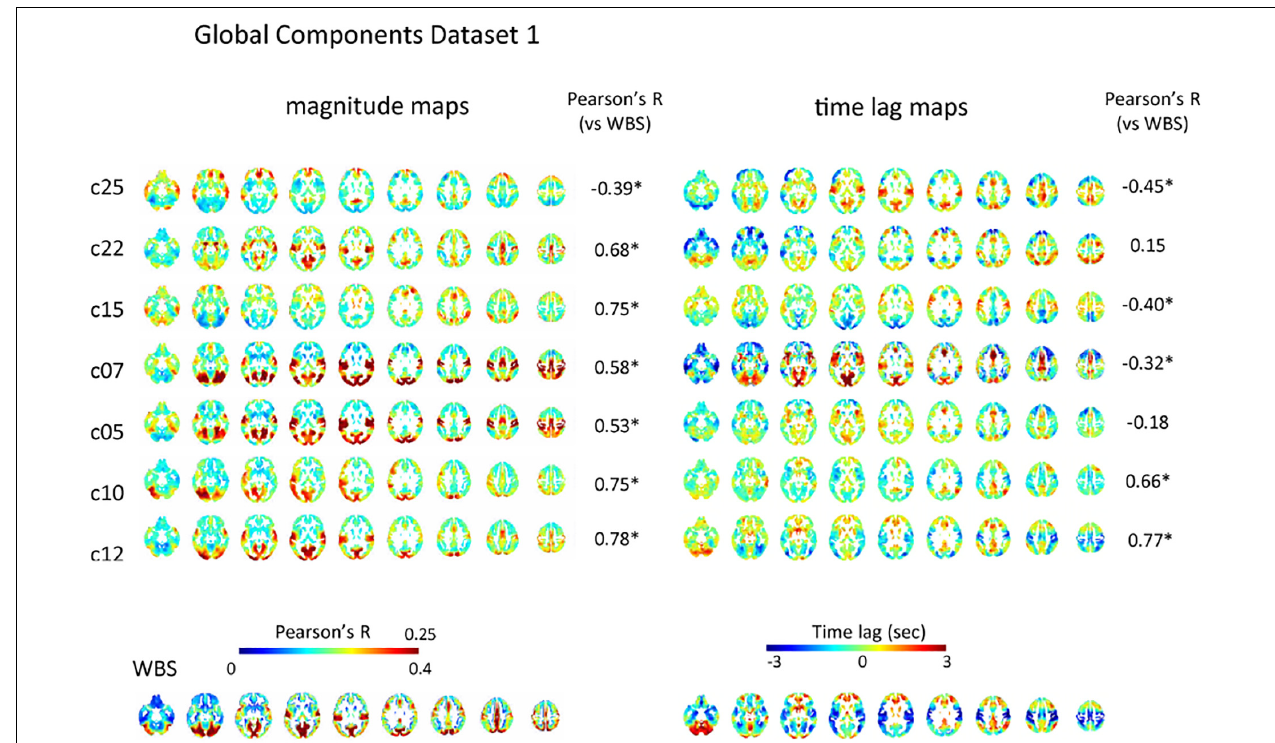
FIGURE 2 | Global component. The spatial distribution of the magnitude of the temporal ICA components for test dataset demonstrates a set of global ICs. The magnitude of the seven global ICs is shown as Pearson’s correlation coefficient with the corresponding time lag structures showing its path. All magnitude maps were significantly correlated with the map obtained using the whole-brain signal (WBS), that is characterized by symmetrical high magnitude areas distributed predominantly in the occipital lobes, as well as in the path of propagation that is characterized by early signal in the primary sensorimotor and visual cortex compared with association areas, frontotemporal basal regions or the cerebellum (bottom row). Five of the seven time lag maps were significantly correlated with that of the whole-brain signal. C25, c07, and c05 show early regions in the rostral and lateral part of the frontal lobes and delayed regions in the medial part of the frontal lobes, insular and inferior frontal gyrus and occipital lobes, while the pattern is almost opposite for c10. C12’s path is characterized by early regions in the sensorimotor, auditory, and visual cortex, as well as delayed regions in the association cortex and posterior cingulate cortex, while c07 shows the opposite pattern. C15 resembles c05, c07, c25 pattern, but the delay in dorsal attention network is more conspicuous. Pearson’s correlation coefficients between time lag and magnitude maps of each global IC and those of the whole-brain signal are also shown.